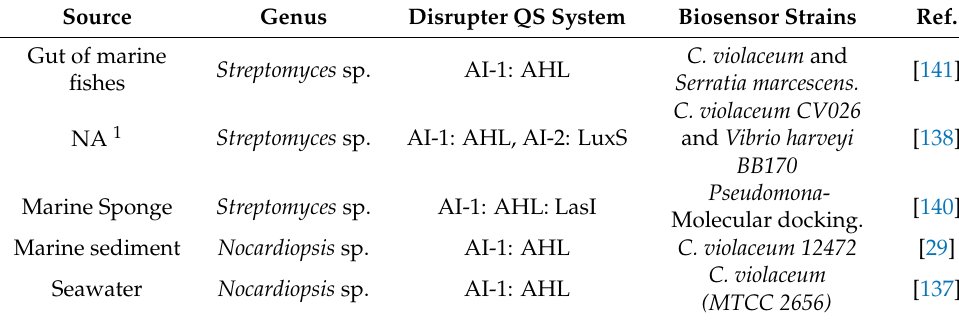
Table 5. Marine actinobacteria with Quorum Quenching (QQ)